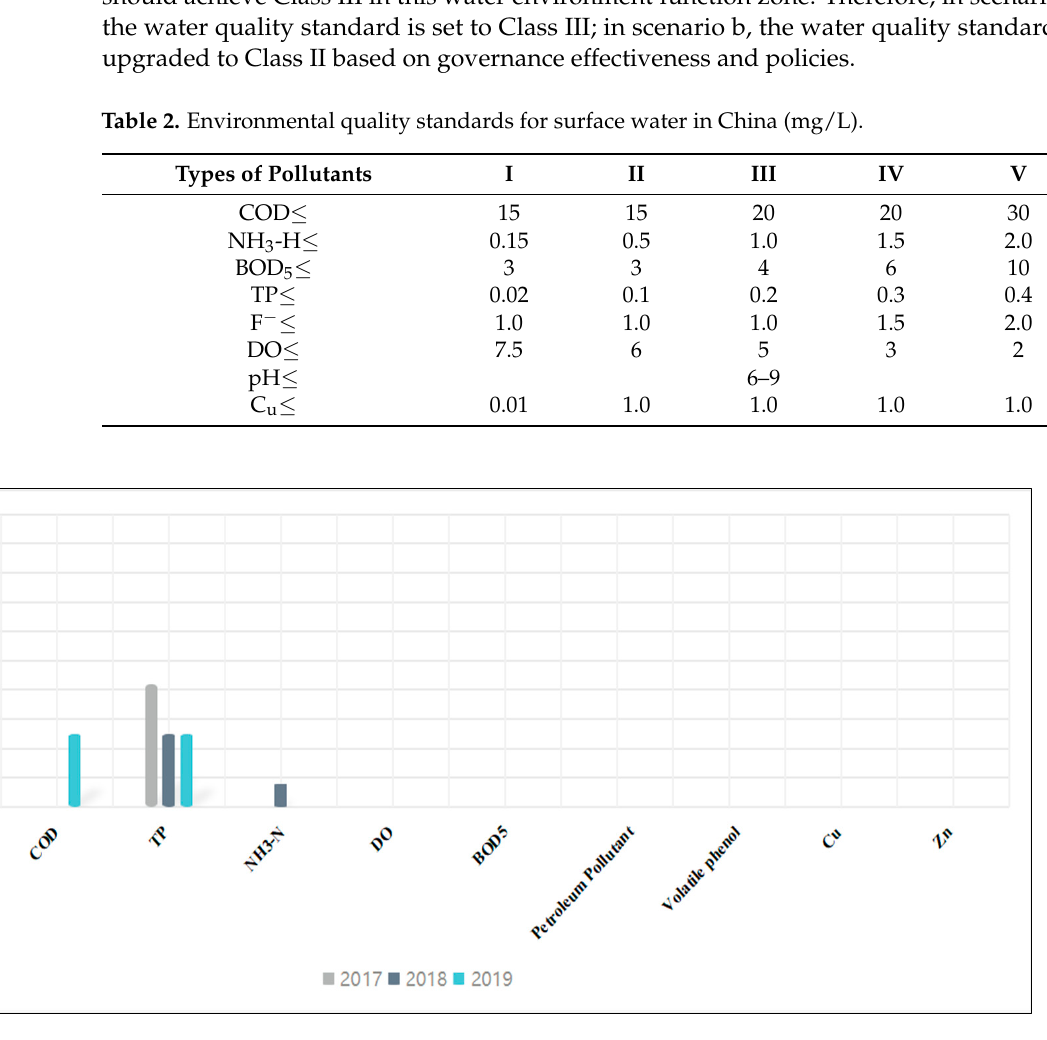
Figure 3. Excessive rate of pollutants in a section of the Bahao Bridge, 2017–2019 .